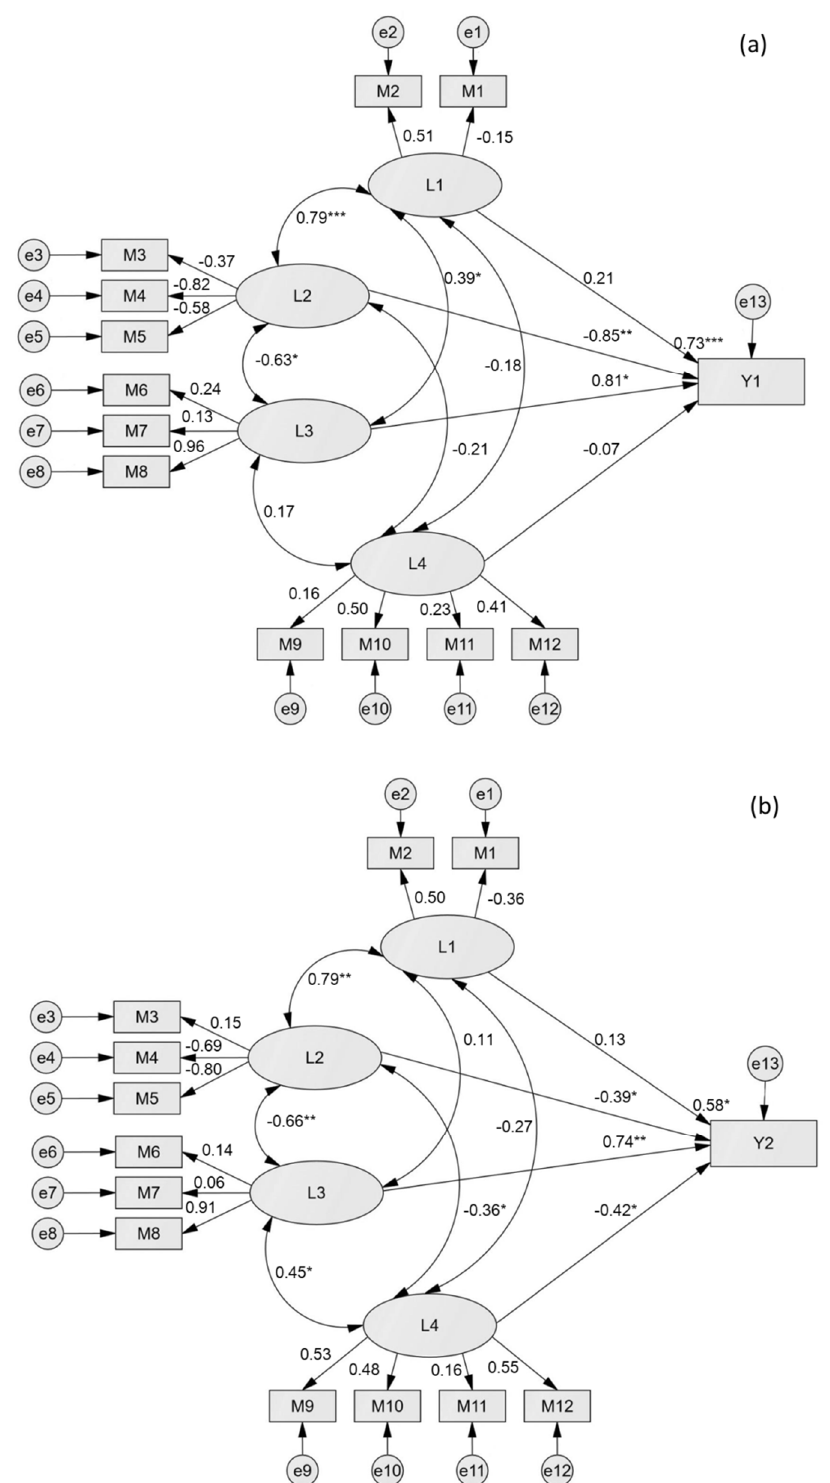
Figure 9. Results of Structural Equation Models for the effects of impact factors on the variation of sand fixation ( a ) and dust retention ( b ) for Grain for Green project.